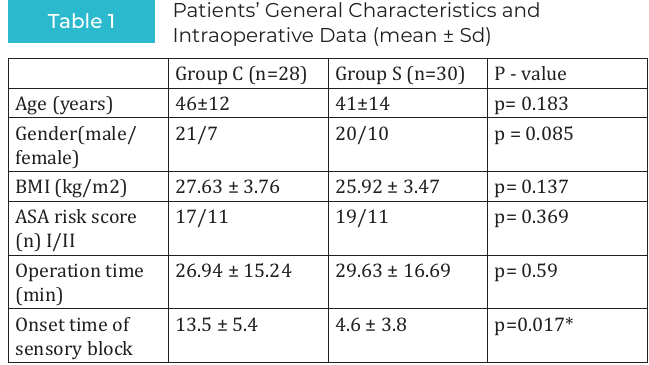
*p<0.05: Onset time of sensory block in Group S was faster than